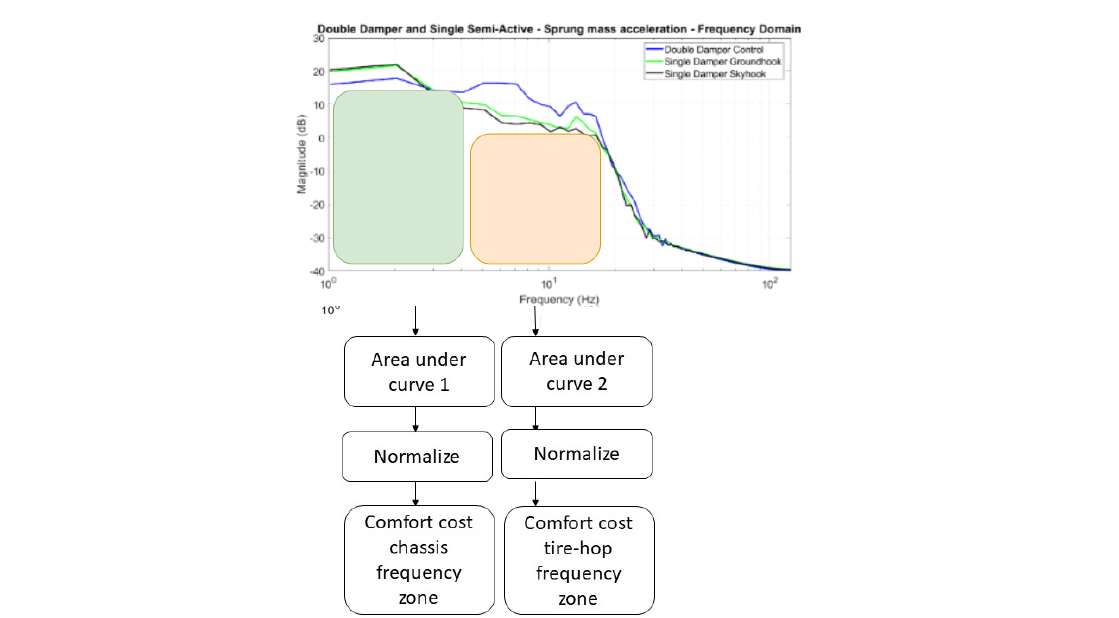
Figure 12. Method of computing comfort